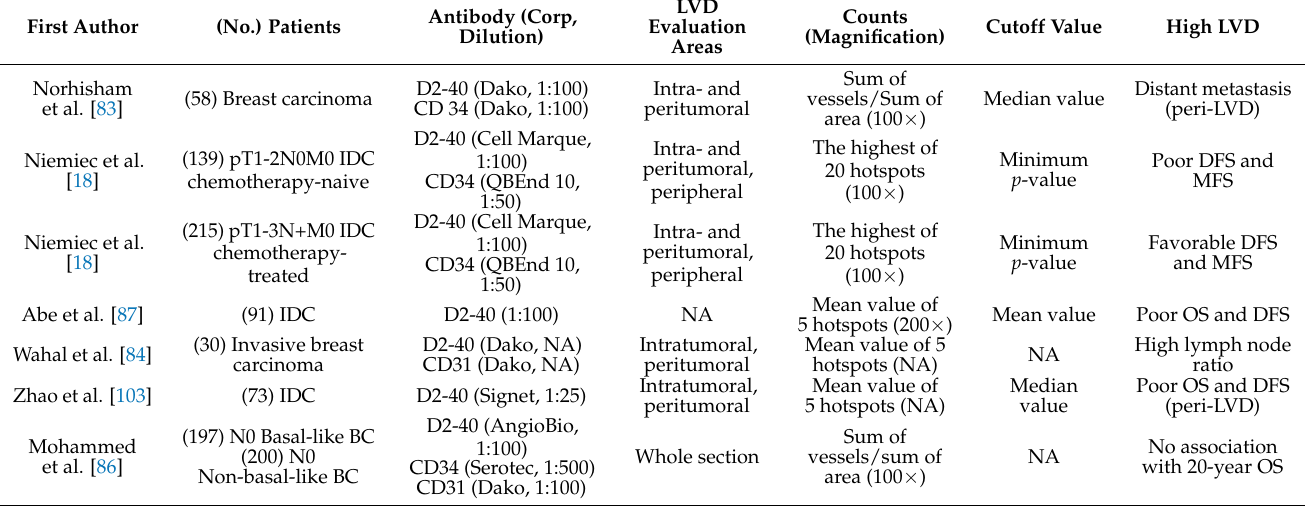
Table 2. Studies on the relationship between the lymphatic vessel density (LVD) and breast cancer survival over the last